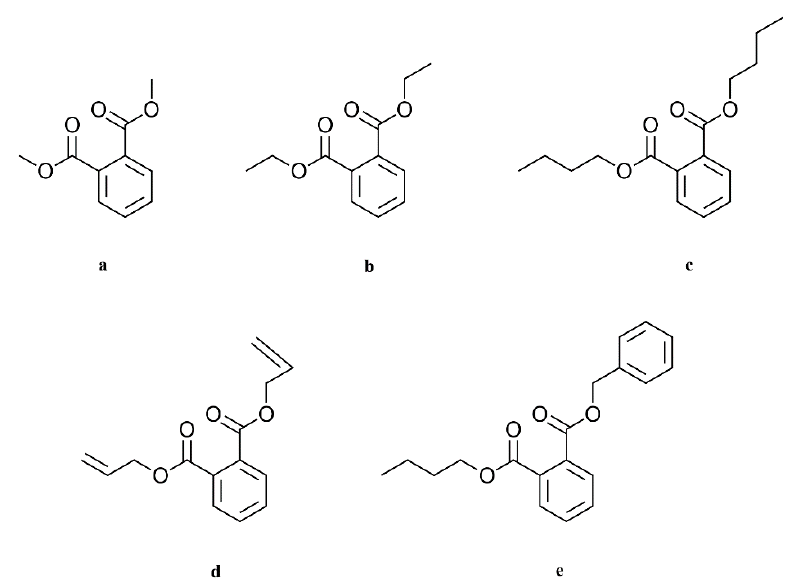
Figure 1. Chemical structures of the respective phthalates: ( a ) dimethyl phthalate, ( b ) diethyl phthalate, ( c ) dibutyl phthalate, ( d ) diallyl phthalate, ( e ) benzyl butyl phthalate .